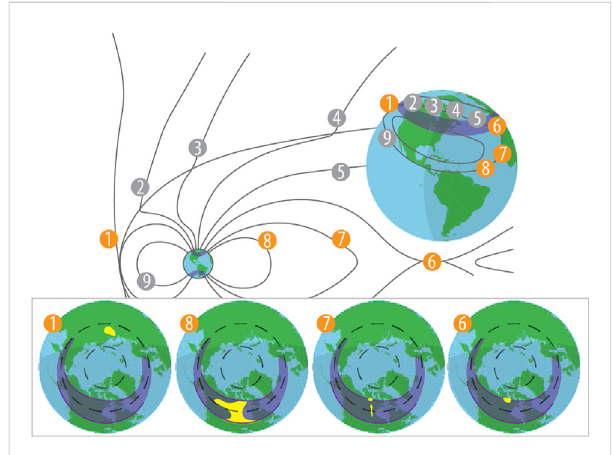
FIGURE 4 STORM ’ s global observations de fi ne the fl ow of energy from the dayside to the magnetotail and back (1 – 9). This fl ow of energy can be used to test models in which bursts of dayside reconnection initiate inward magnetopause motion and transient enhancements in the intensity of the dayside proton aurora (1), followed by a nightside PBI (6), auroral streamers (7), and fi nally substorm onset